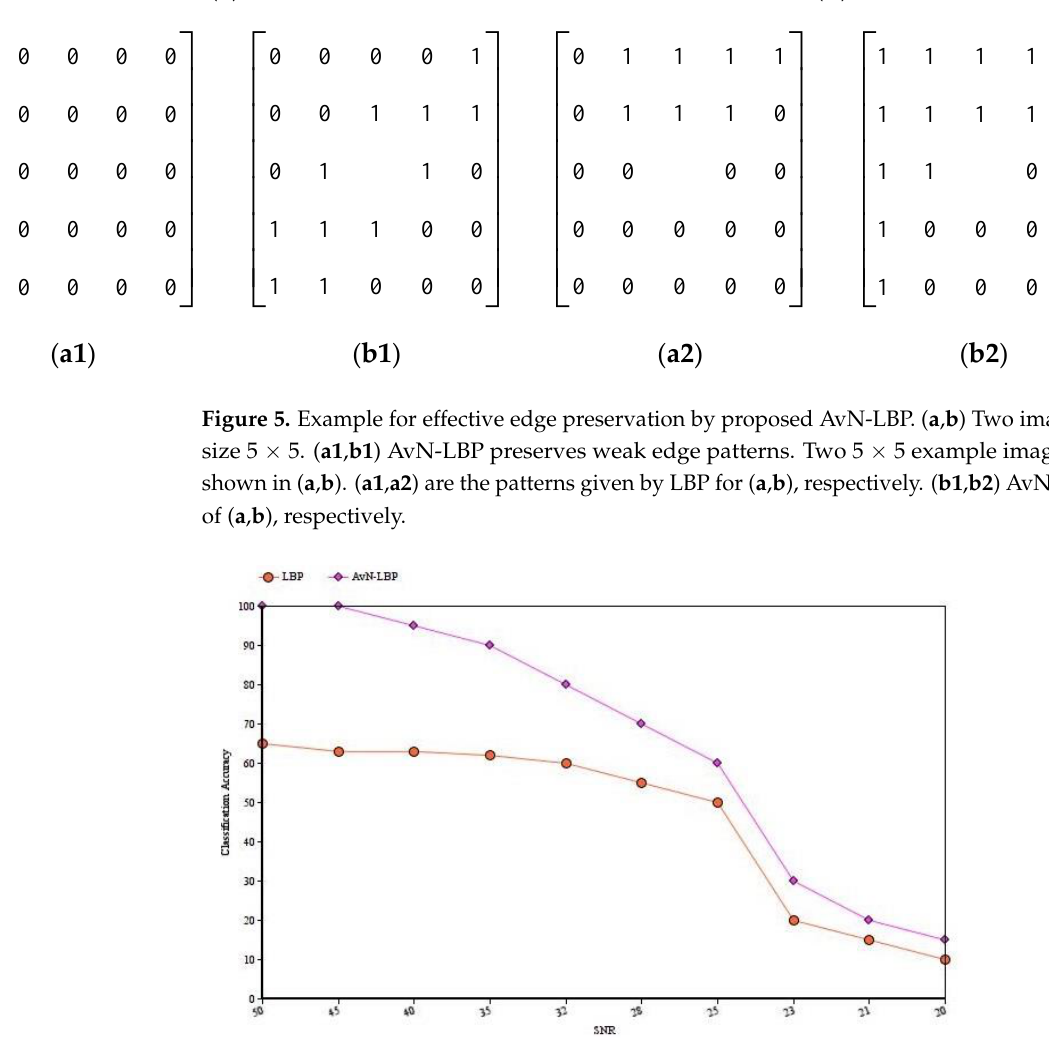
Figure 6. Comparison of the robustness of the proposed AvN-LBP descriptor to noise and the comparison with conventional LBP.